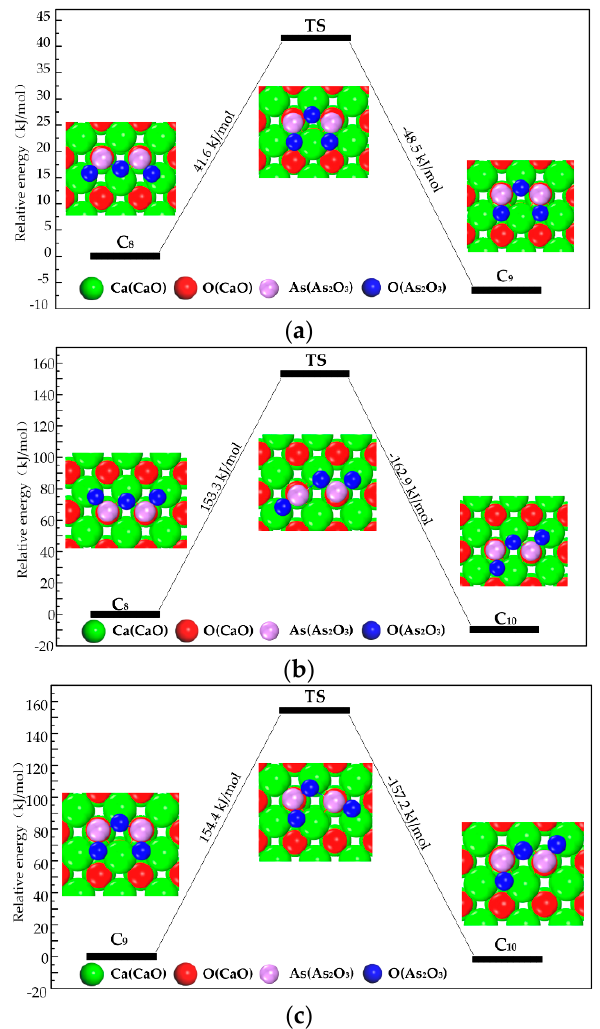
Figure 5. Transformation path of Category IV. ( a ) Reaction path of C 8 to C 9 ; ( b ) Reaction path of C 8 to C 10 ; ( c ) Reaction path of C 9 to C 10 .